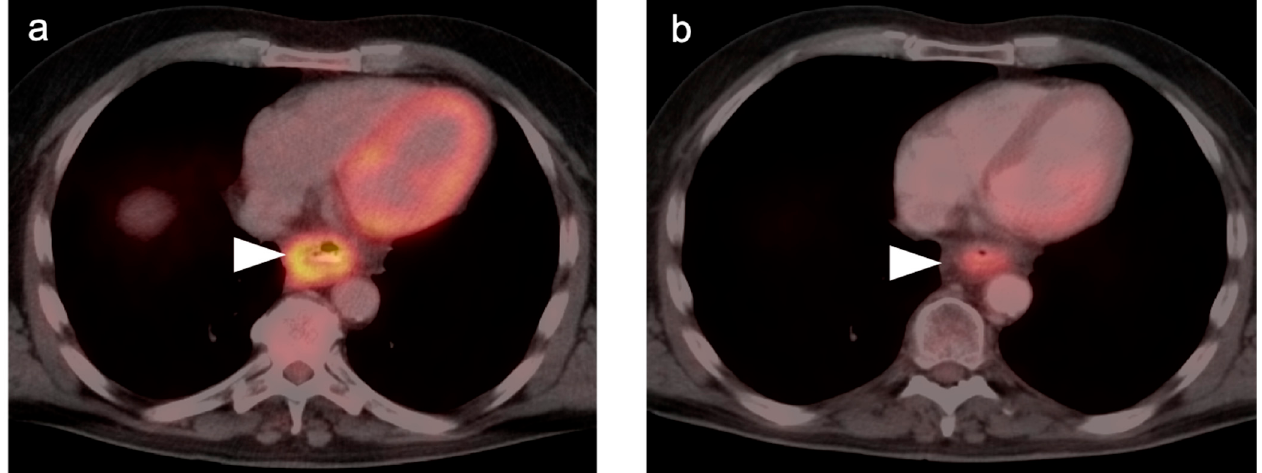
Figure 2. Persistent tumor following CRT. ( a ) Pre-treatment axial fused FDG PET-CT demonstrates a hypermetabolic tumor in the mid-esophagus (white arrowhead); ( b ) Axial fused FDG PET-CT image 12 weeks following completion of CRT demonstrates persistent, although improved, hypermetabolic soft tissue mass in the mid-esophagus (white arrowhead). Biopsy confirmed the presence of persistent viable tumor.